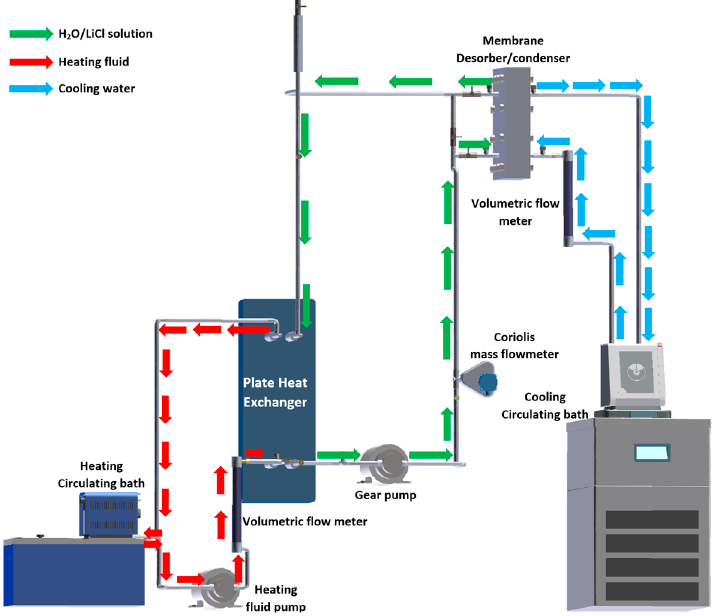
Figure 2. Schematic diagram of the experimental setup.